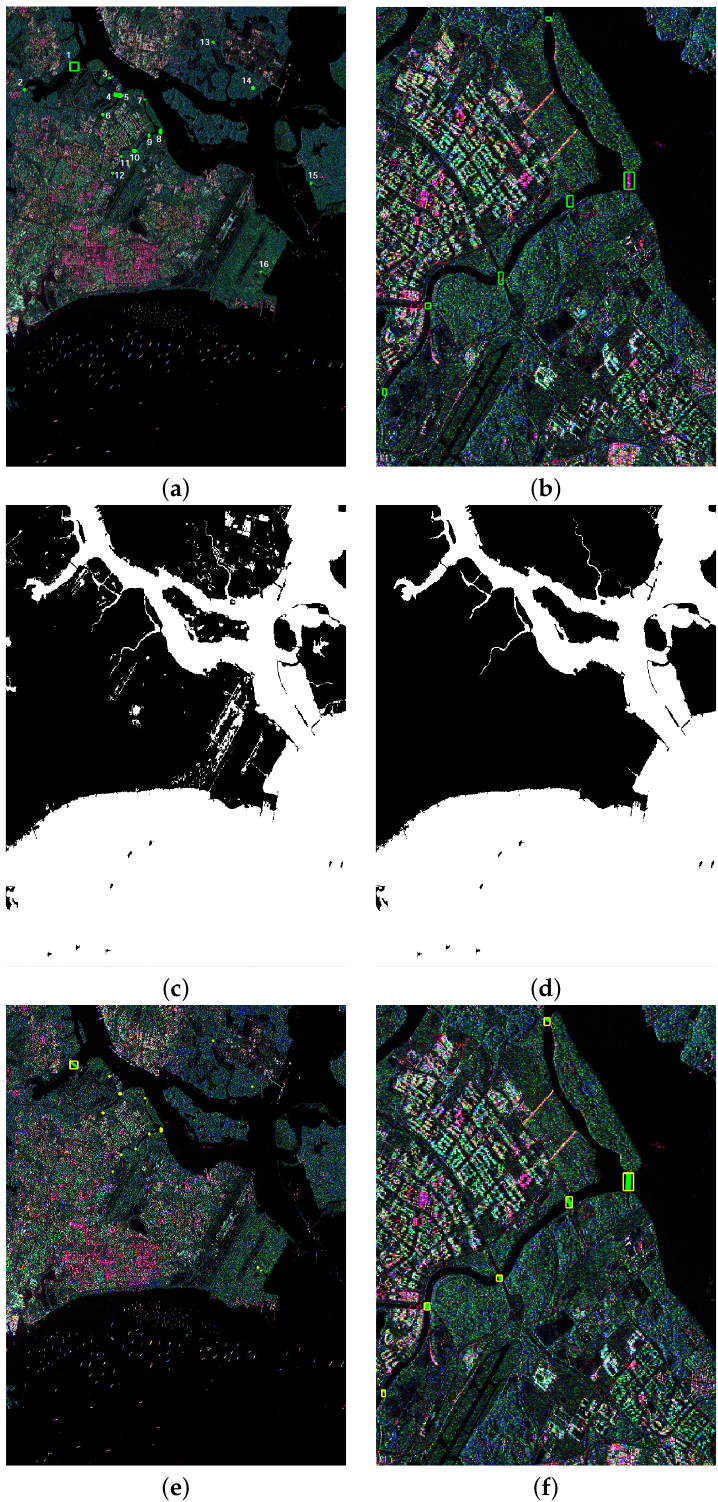
Figure 11. Bridge detection results of data from RADARSAT-2 in Singapore: ( a ) the Pauli pseudocolor image and the ground truth of the bridges, where the bridges are marked by green boxes; ( b ) an enlarged view of part of the image ( a ) near a narrow tributary; ( c ) the water branch extraction result; ( d ) the water network connection result; ( e ) the bridge detection result; ( f ) the detection result of the enlarged part of ( b